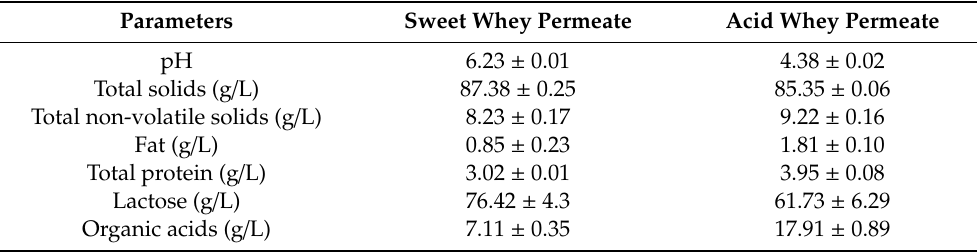
Table 1. Physicochemical characteristics of sweet whey permeate and acid whey